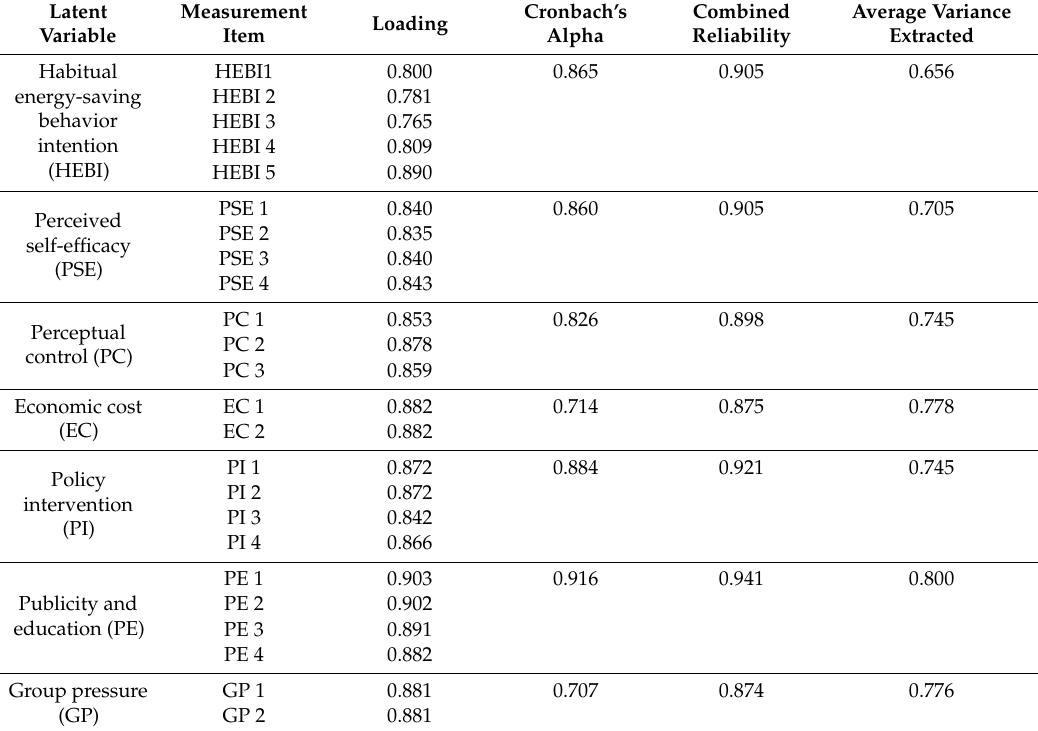
Table 2. Reliability and